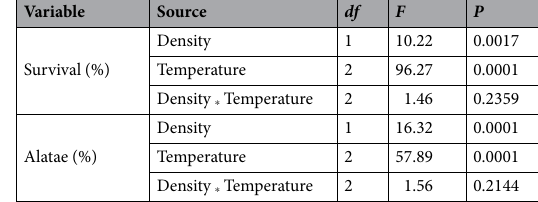
Table 3. Summarized models of the effects of density 1 and temperature 2 on the survival and alatae of Rhopalosiphum maidis using General Linear Model (GLM). 1 Density: 10 and 50 aphids/unit; 2 Temperature pattern: 24/39 °C, 26/39 °C and 28/39